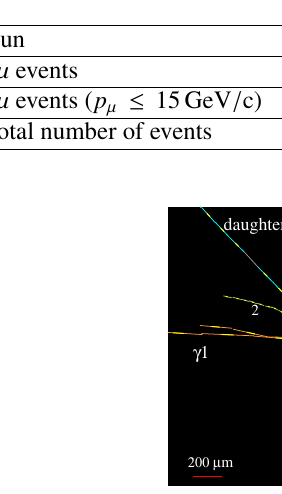
Table 2. Numbers of events used for the ν μ → ν τ oscillation analysis.